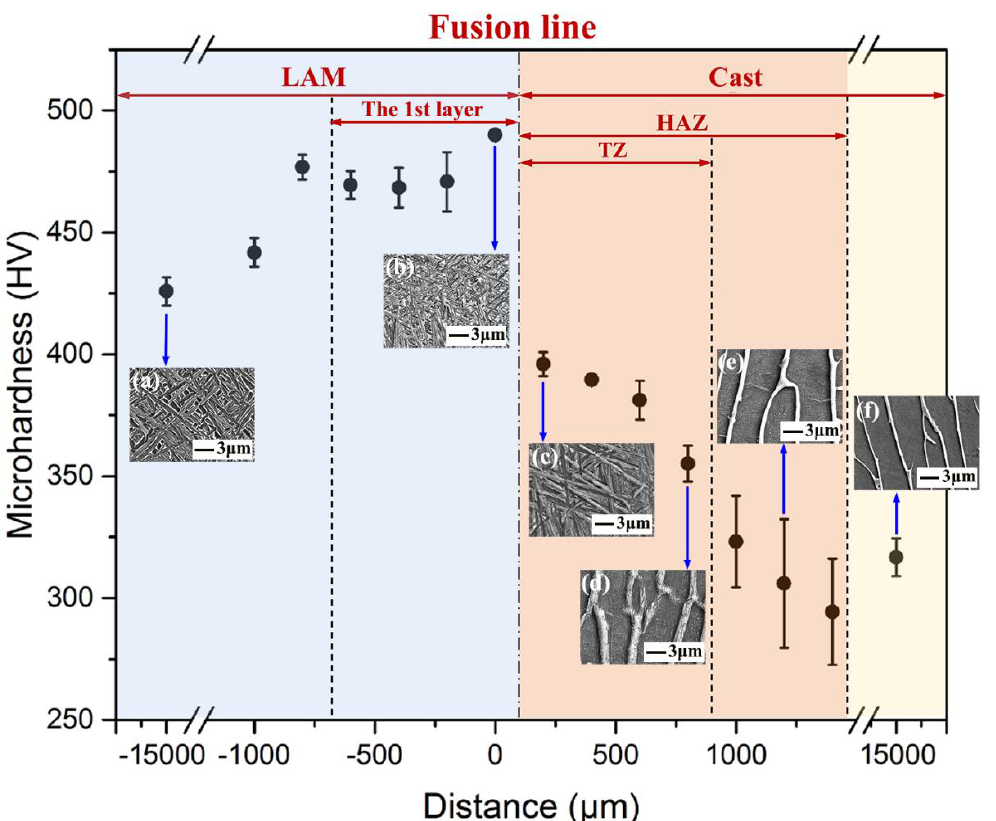
Figure 4. The microhardness profile of the hybrid manufacturing TC4 sample, in which the microstructure images correspond to some of the typical locations, is presented.